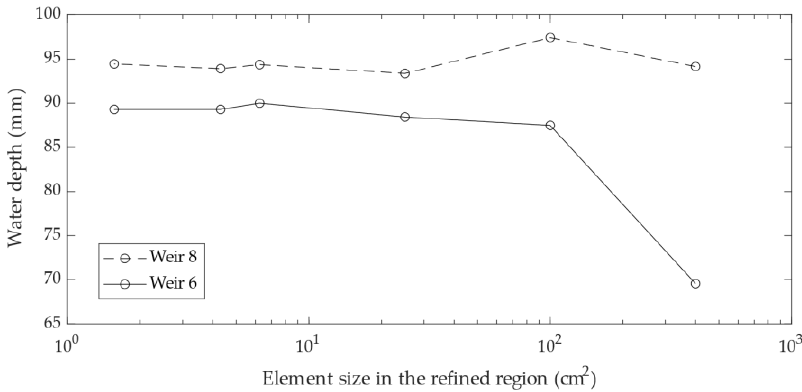
Figure 5. Results of the mesh convergence analysis. Water depth was measured at a reference point located 10 cm upstream of the weir in the centre line of the flume. Water depth refers to the depth above the crest of the weir.